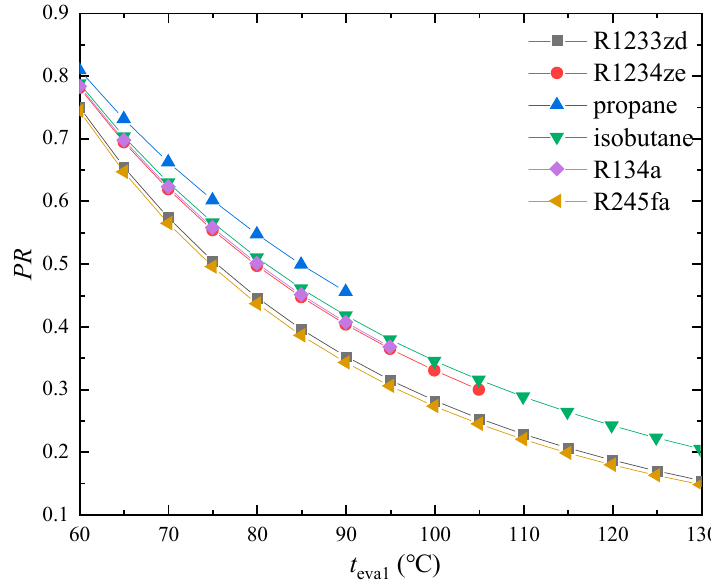
Figure 5. Pressure ratio for the geothermal fluid temperature of 140 °C.